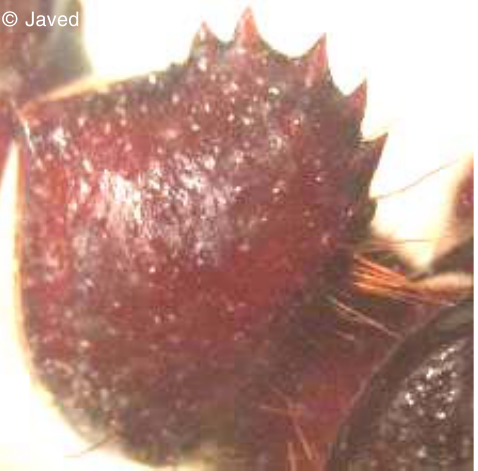
Image 4. Dorsal view of left trochanter of pedipalp